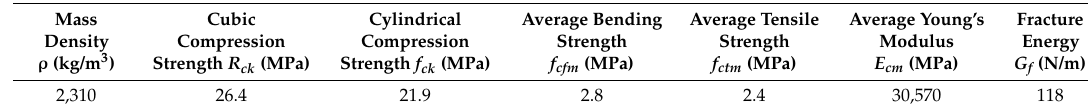
Table 2. Mechanical properties of specimens.